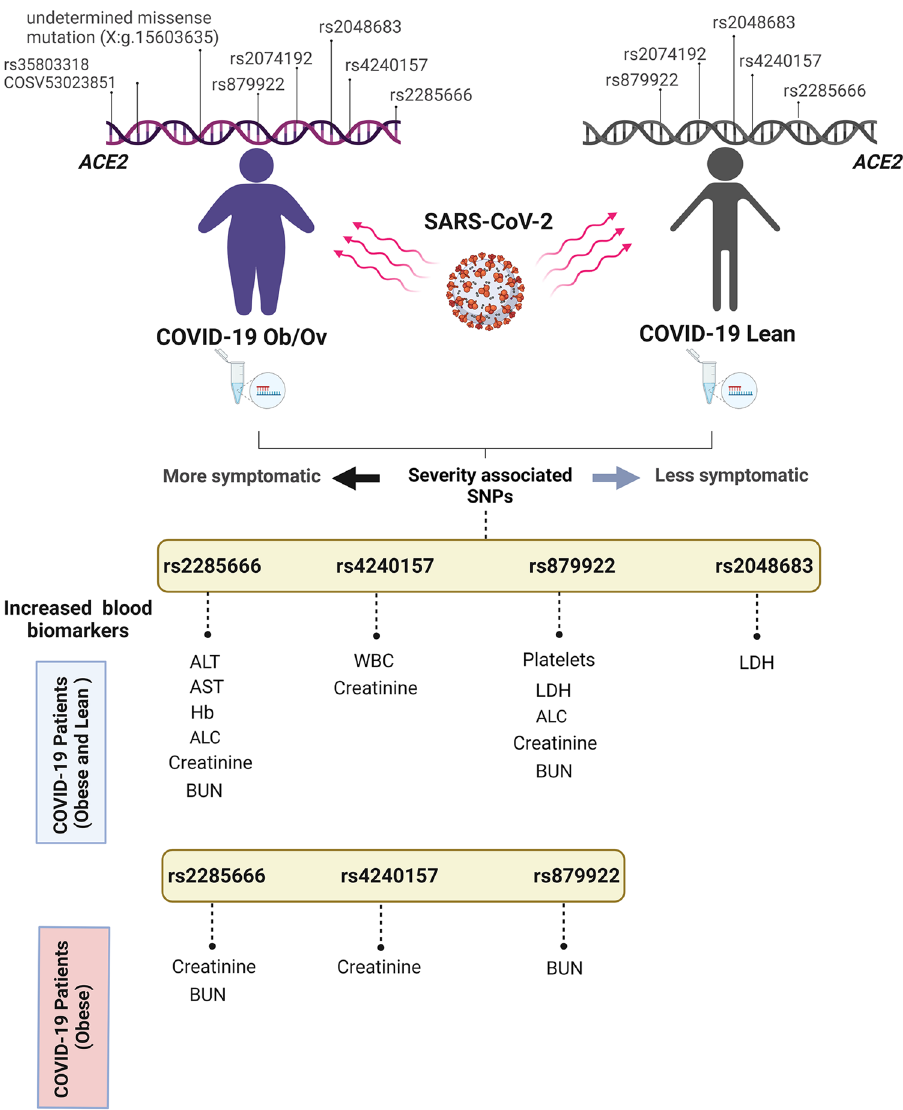
Figure 9. A representative scheme summarizing the ACE2 variants impact on blood biomarkers in COVID-19 lean and obese